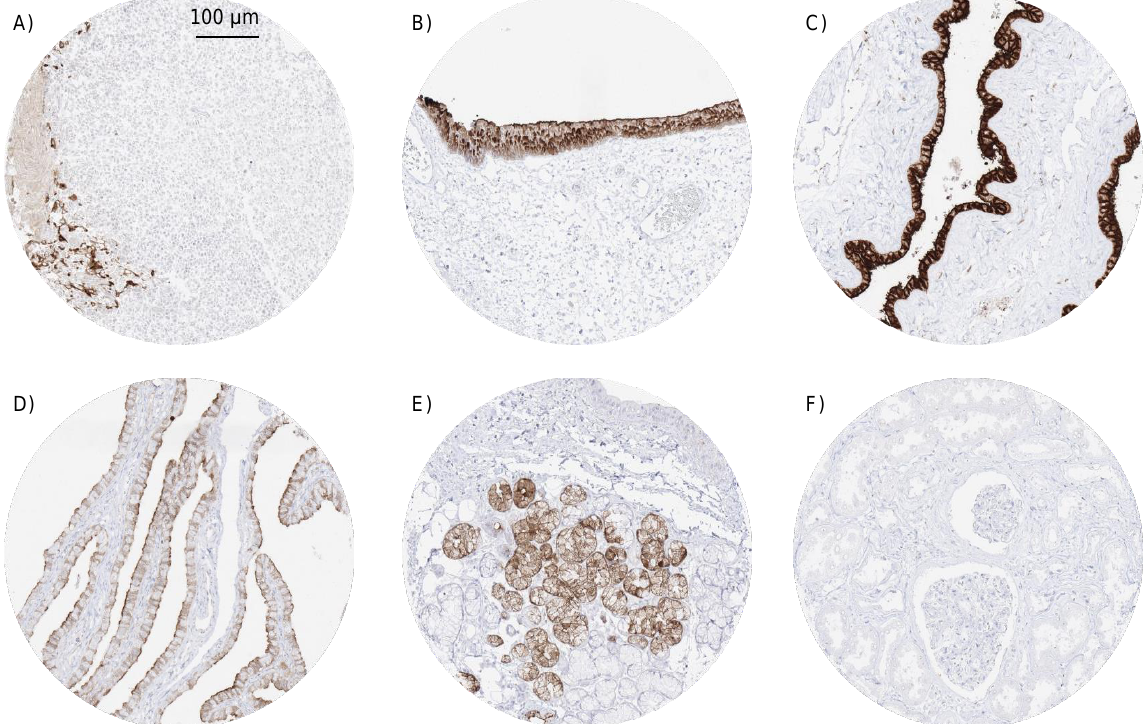
Figure 1. Mesothelin (MSLN) immunostaining in normal tissues. Among normal tissues, MSLN immunostaining is particularly strong in a fraction of squamous epithelial cells in tonsil crypts ( A ), the anal transitional epithelium ( B ) and amnion cells ( C ). A somewhat weaker MSLN staining is seen at the apical cell border and in cilia of fallopian tube epithelium ( D ) and in a fraction mucinous cells (often grouped together) in sublingual glands ( E ). MSLN immunostaining was consistently lacking in the kidney ( F ).